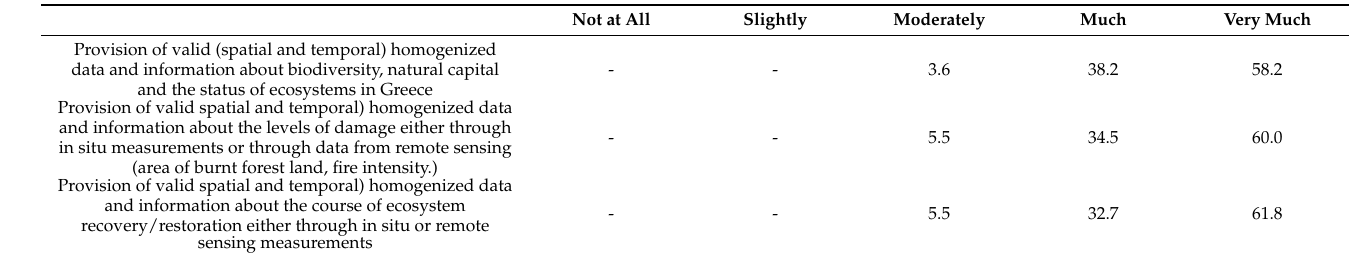
Table 8. Percentages regarding respondents’ views on the data and information that should be provided by Hub ( N =